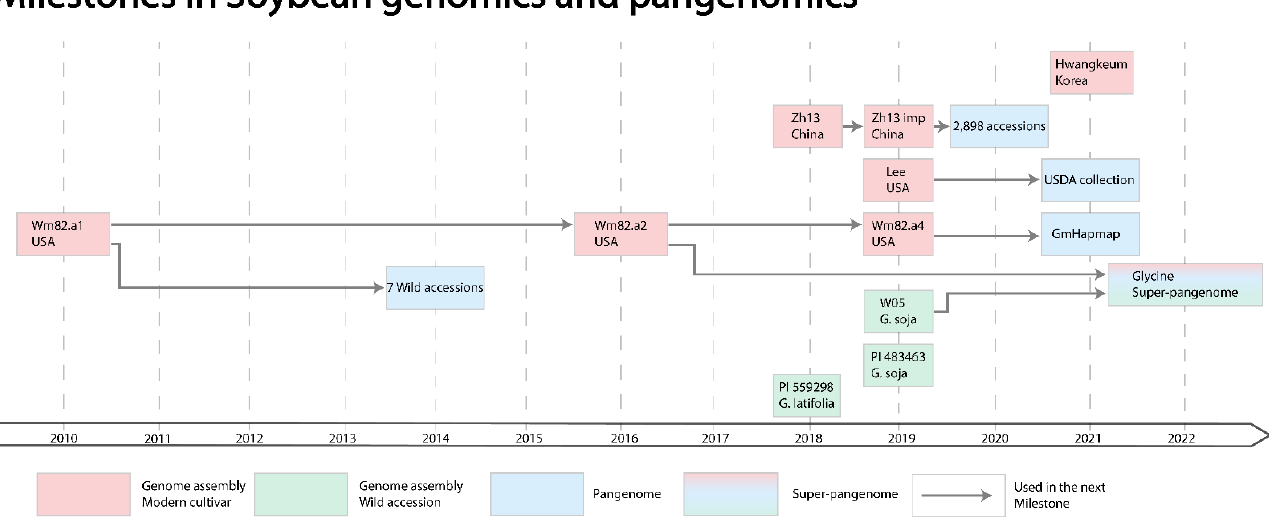
Figure 2. Milestones progressing soybean genomics and pangenomics. Red boxes indicate genome assemblies of modern cultivars (Wm82.a1/a2/a3— G. max Williams82, first, second and fourth revision, Lee— G. max Lee, Zh13, Zh13 imp— G. max Zhonhuang 13 and Zhonghuang 13 improved), green boxes indicate wild genome assemblies (W05— G. soja accession W05, PI 483463— G. soja accession, PI 559298— G. latifolia accession), blue boxes indicate pangenomes, including the used accessions for their construction, and the red-blue-green box depicts the Glycine super-pangenome, including G. max , G. soja and 7 perennial Glycines . Arrows indicate the use of a constructed genome assembly in a later study.